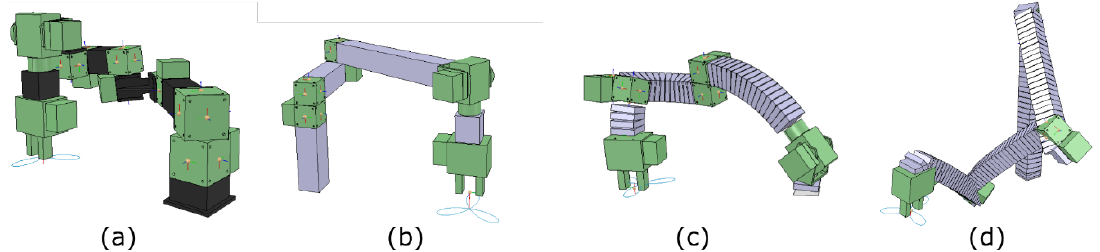
Figure 17. Best results for task 1: ( a ) basic links; ( b ) linear links; ( c ) rounded links; ( d ) Hermite spline links.